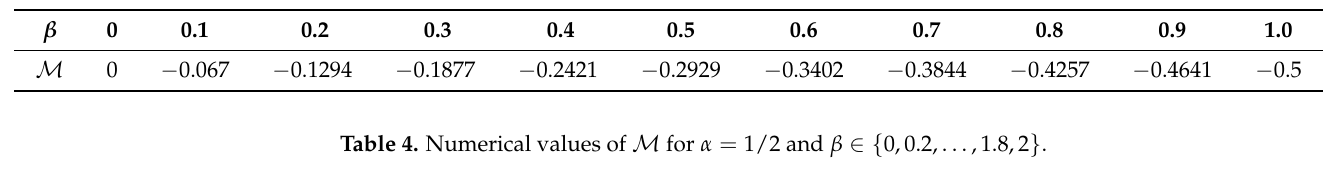
Table 3. Numerical values of M for α = 1 and β ∈ { 0,0.1, . . . ,0.9,1 } .